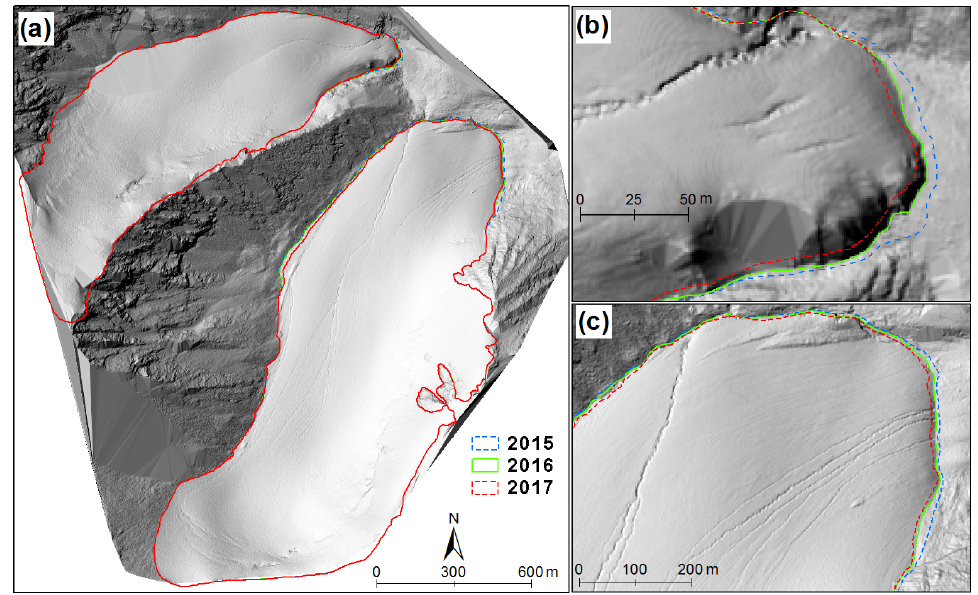
Figure 2. (a) Shaded reliefs of Urumqi Glacier No. 1 margin calculated based on the TLS-derived DEM (on 1 September 2016) with the glacier boundary in 2015 (blue), 2016 (green) and 2017 (red). Glacier terminus variations in the west branch (b) and east branch (c) are also shown. Table 2. Error or SD ( σ MSA ) of multi-station adjustment (MSA) and the number of points ( n ) used for multi-temporal registration of two ) are measures of error derived by calculating elevation changes from consecutive campaigns,the mean ( µ ) and the standard error ( σ (cid:49)h TLS TLS over stable terrain (off-glacier) for 2015 summer (25 April–2 September 2015), 2015–2016 (2 September 2015–1 September 2016), 2016 summer (2 May–1 September 2016), and 2016–2017 (1 September 2016–27 August 2017). Period Error or Number of Mean elevation Standard error of elevation SD of MSA points changes over stable changes over stable (m) terrain (m) terrain (m) 0.28